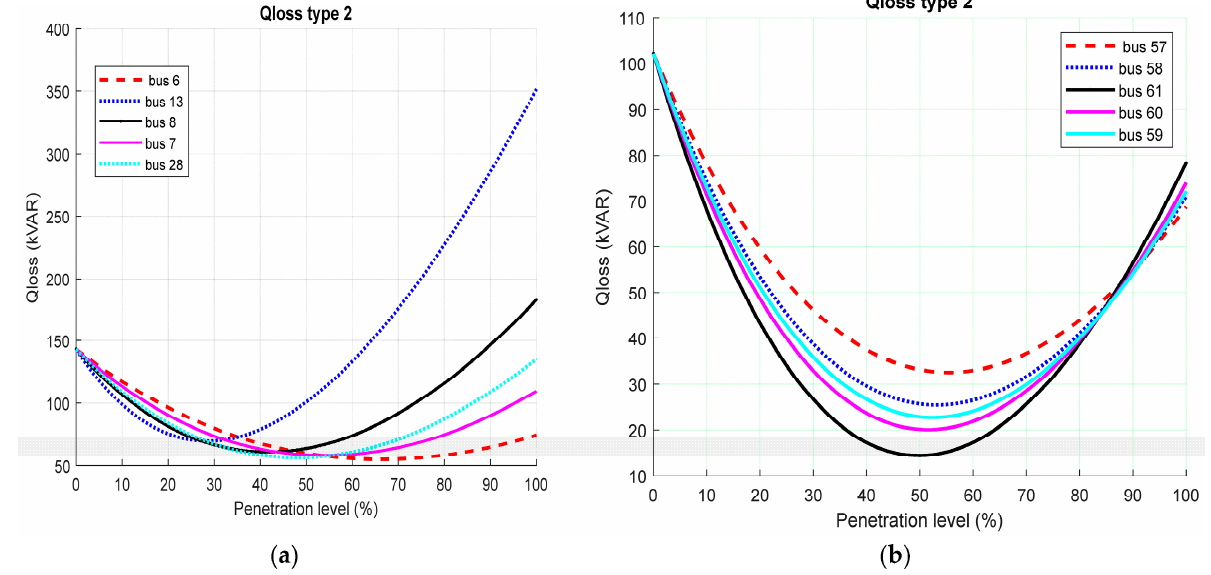
Figure 17. Reactive power loss when Type 2 DG was interconnected to selected nodes of IEEE ( a ) 33-bus ( b ) 69-bus RDNs.